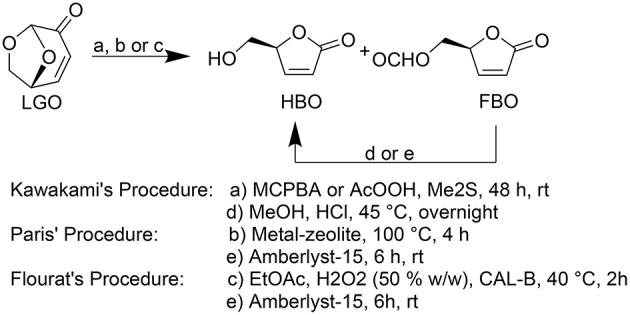
Baeyer-Villiger oxidation of LGO into HBO and FBO following Kawakami (Kawakami et al., 1990), Paris (Paris et al., 2013), and Flourat's (Flourat et al., 2014) procedures.